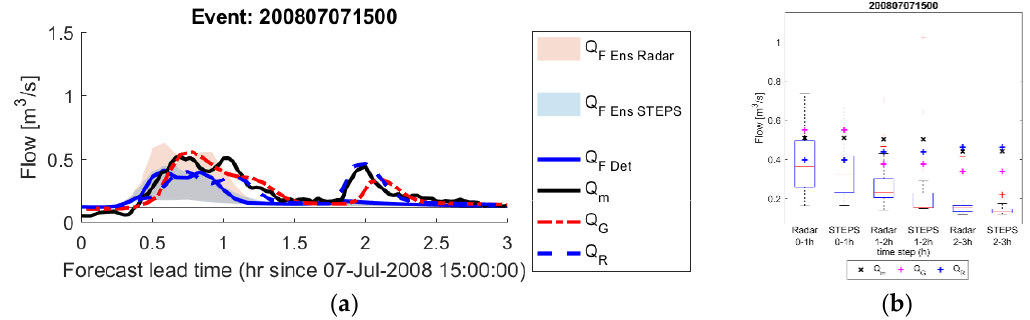
Figure 11. Flows ( a ) and peak flows ( b ) for events on 07 July 2008 starting at 15:00. Q F Ens Radar, Q F Ens STEPS , Q F Det , Q m , Q G and Q R are, respectively, forecasted radar ensemble flows, forecasted STEPS ensemble flows, forecasted deterministic flow, measured flow, estimated gauge flow and estimated radar flow. Geosciences 2018 , 8 , 297